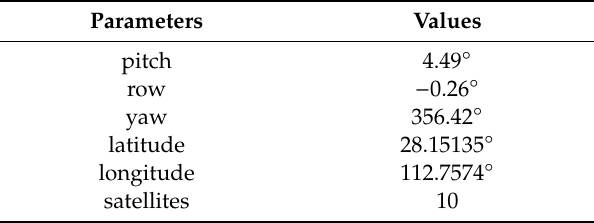
Figure 26. A photo taken in the experimental area. Table 5. Location information of the image label.